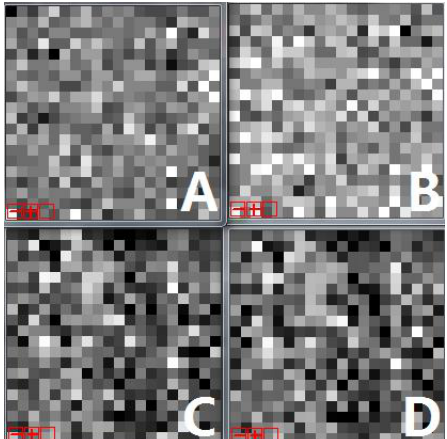
Figure 4. Correlation analysis, A, B, C, and D are a part of four flat-field images, displayed in ENVI’s zoom window, 20 × 20 pixels,  = 0.402867,  = AB CD